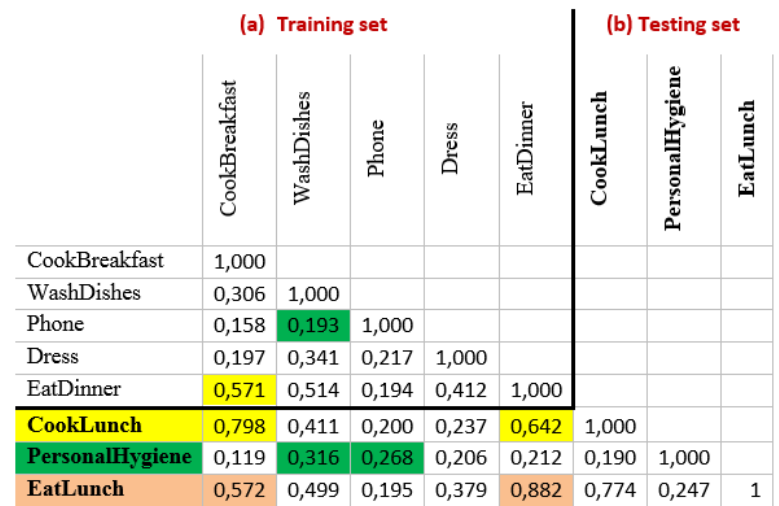
Figure 6. Correlation between seen and unseen activities in scenario (one). ( a ) Training set; ( b ) Testing